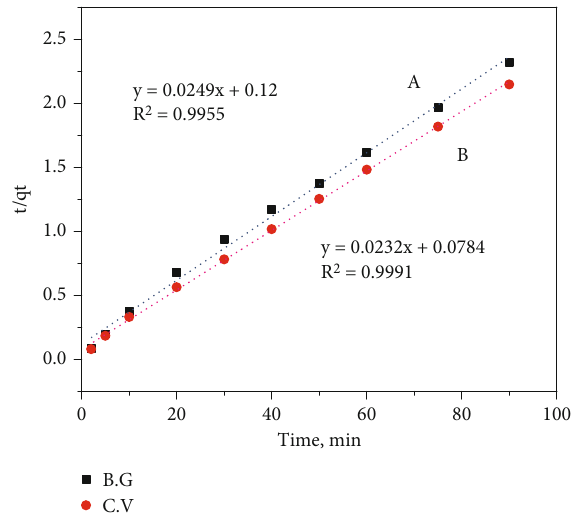
Figure 15: Pseudo-second-order depiction of B.G. and C.V. dyes ’ adsorption on the binary P3NT/30%AgTiO Experimental conditions are illustrated in the batch extraction step.